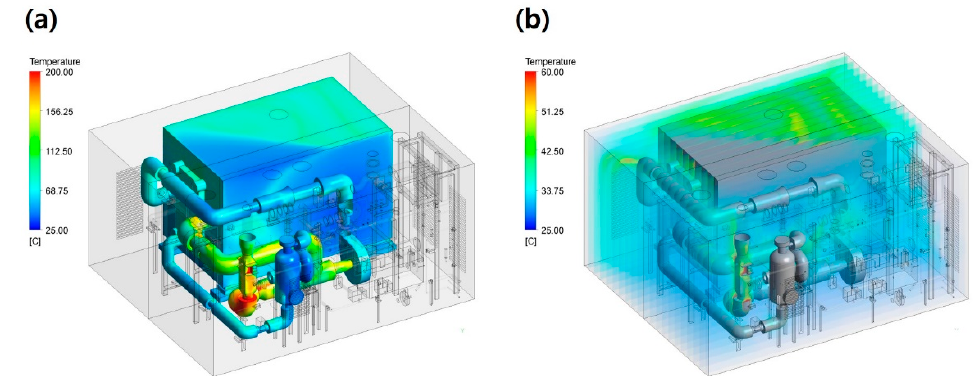
Figure 9. Temperature distribution of the MCFC stack package at outer temperature 25 °C: ( a ) surface temperature at heating pipe and ( b ) yz plane.